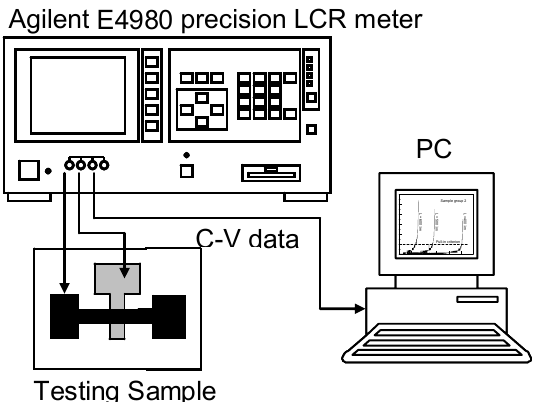
Figure 5. Schematic of the experiment setup for pull-in voltage detection.